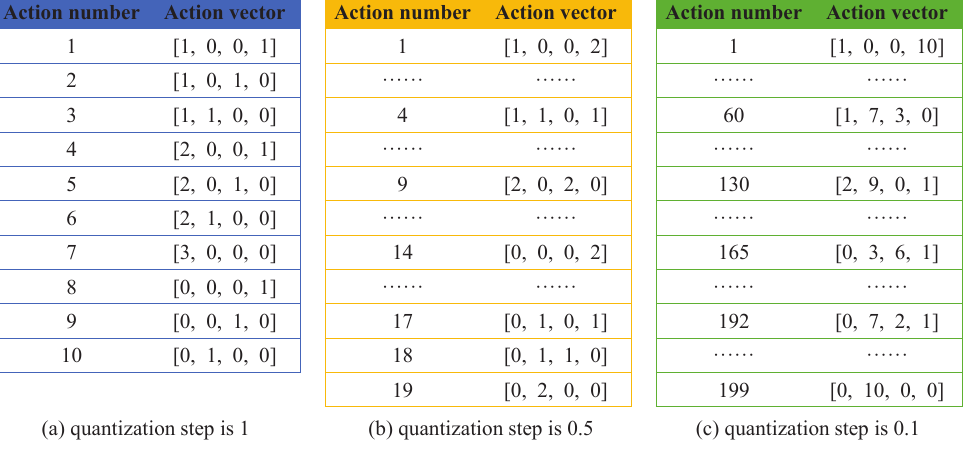
Figure 7. The relationship between action number and action vector for the jammer under different quantization steps.